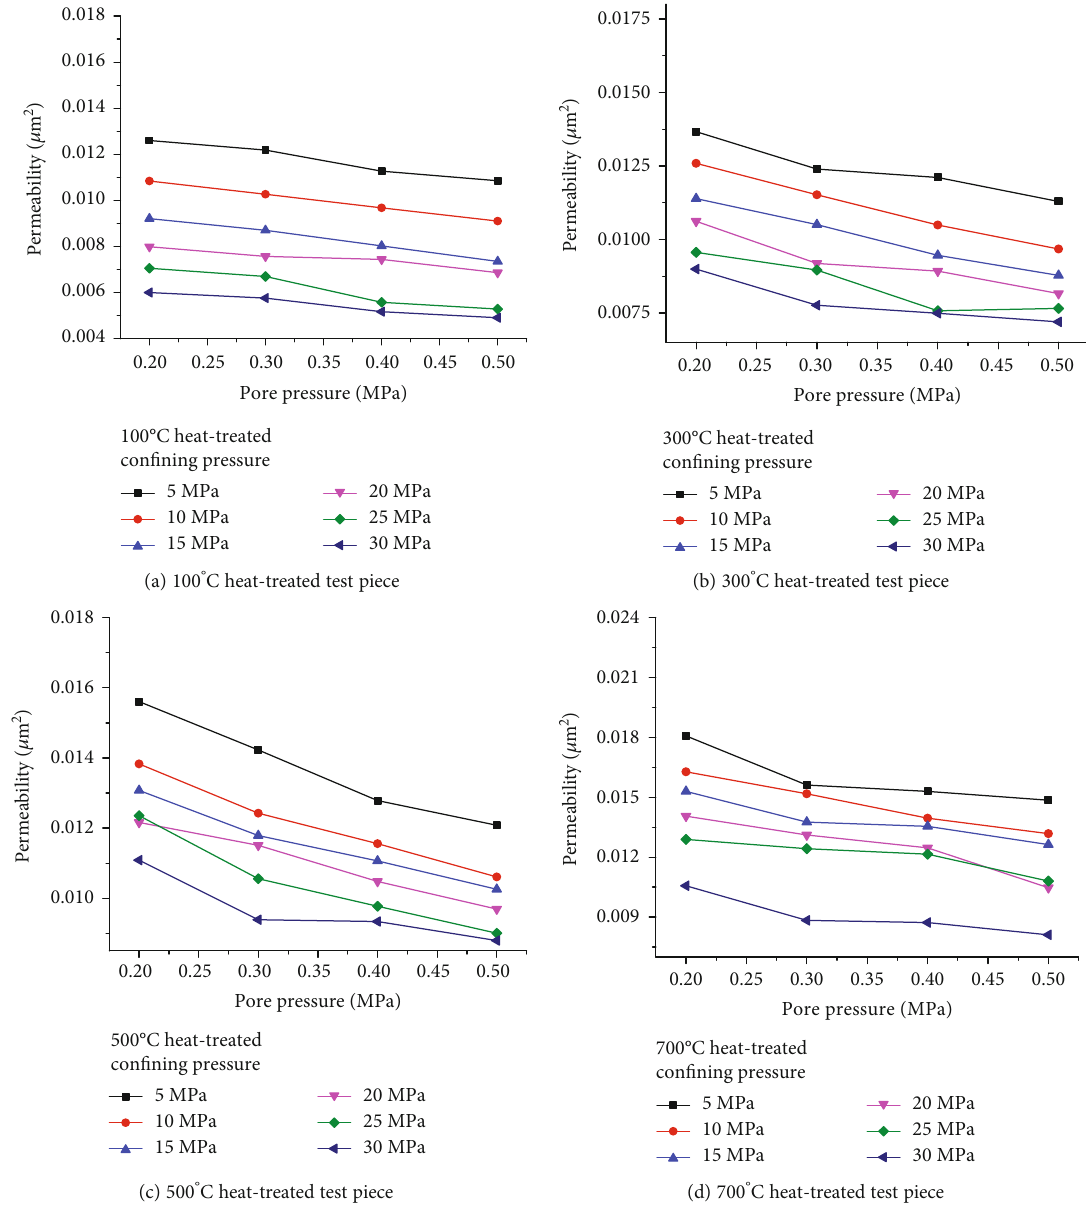
Figure 5: Permeability changes under the di ff erent pore pressure